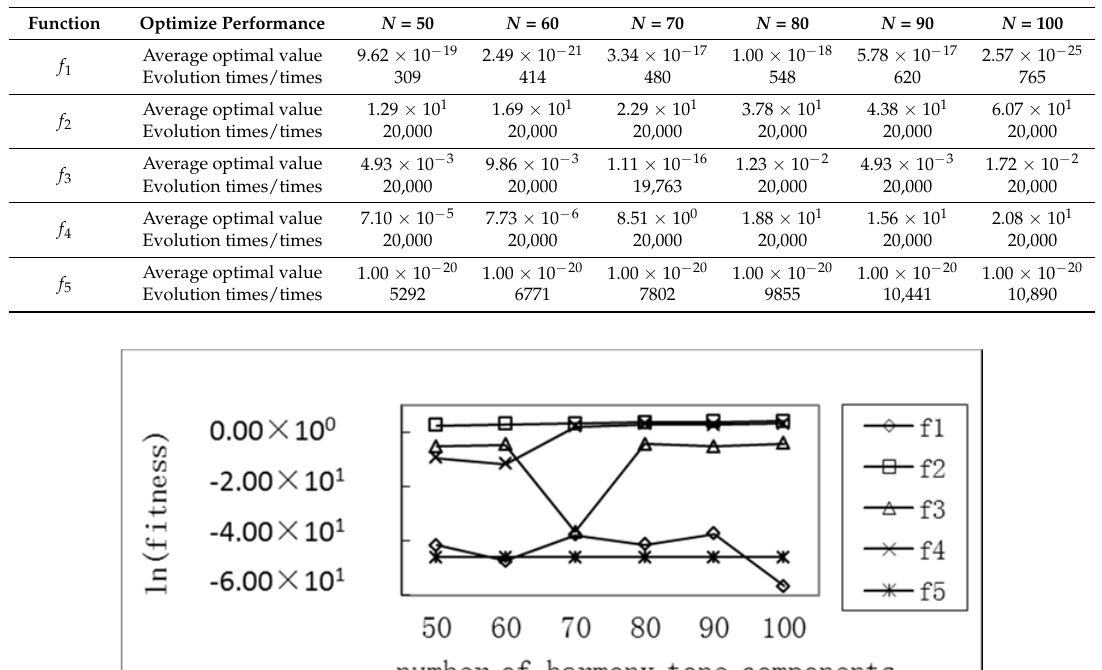
Table 6. Comparisons of the convergence performance with different harmony memory sizes of the SC ‐ AHS algorithm.